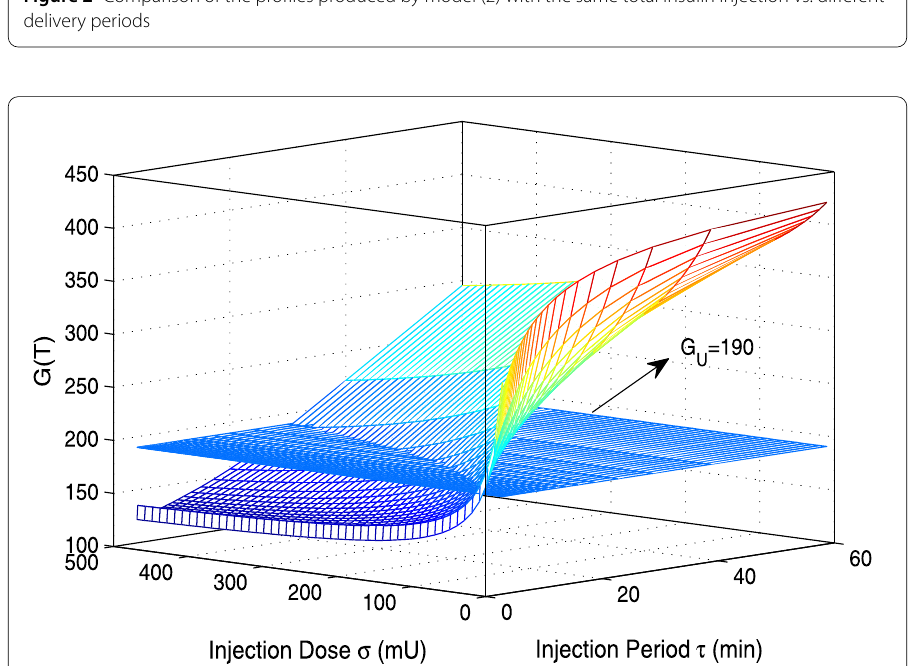
Figure 3 Surface of G ( T ) as a function of σ and τ produced by Model (2) with G 0 = 210 mg/dl, σ = 400 mU